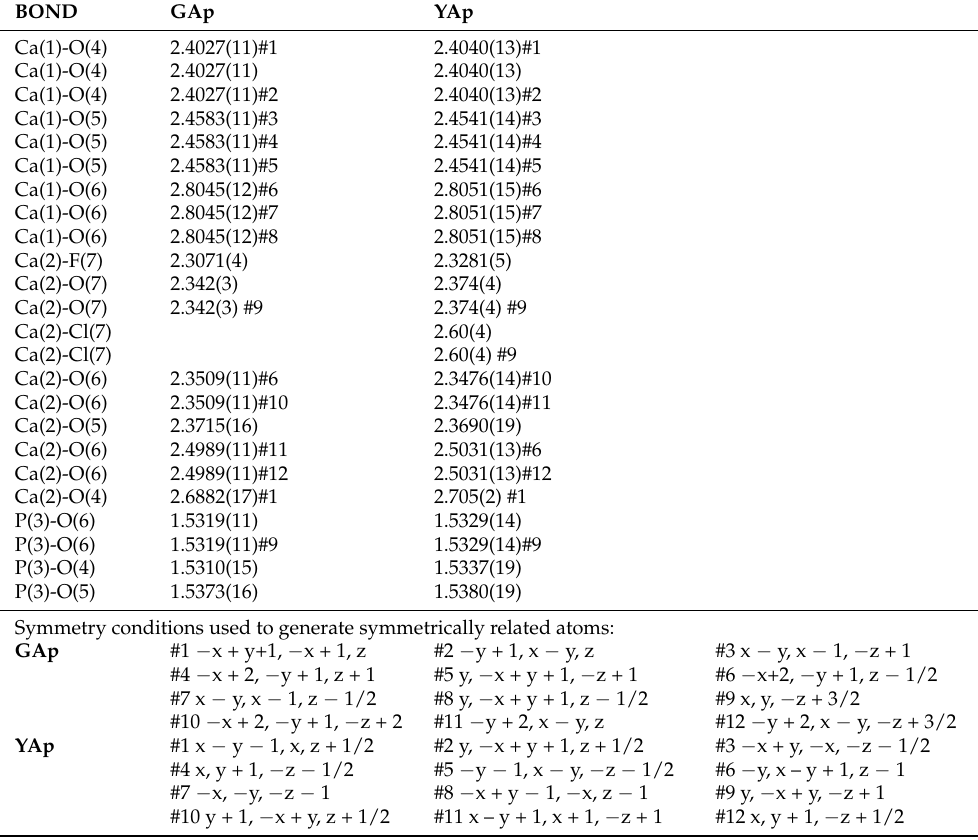
Table A5. Comparison of selected bond length [Å] for GAp and YAp.